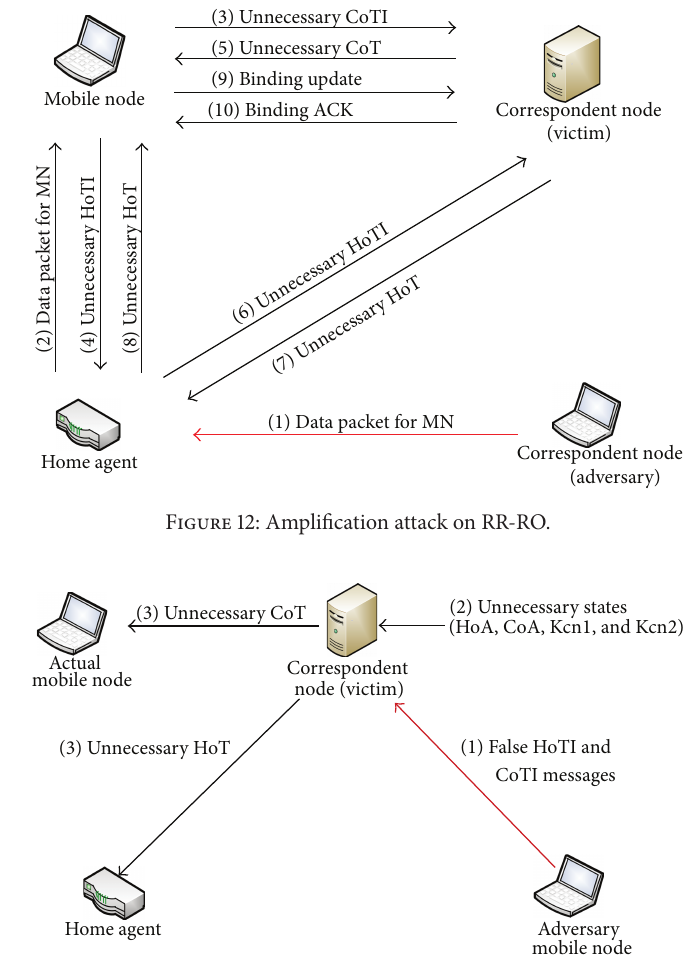
Figure 13: DoS attack on RR-RO.